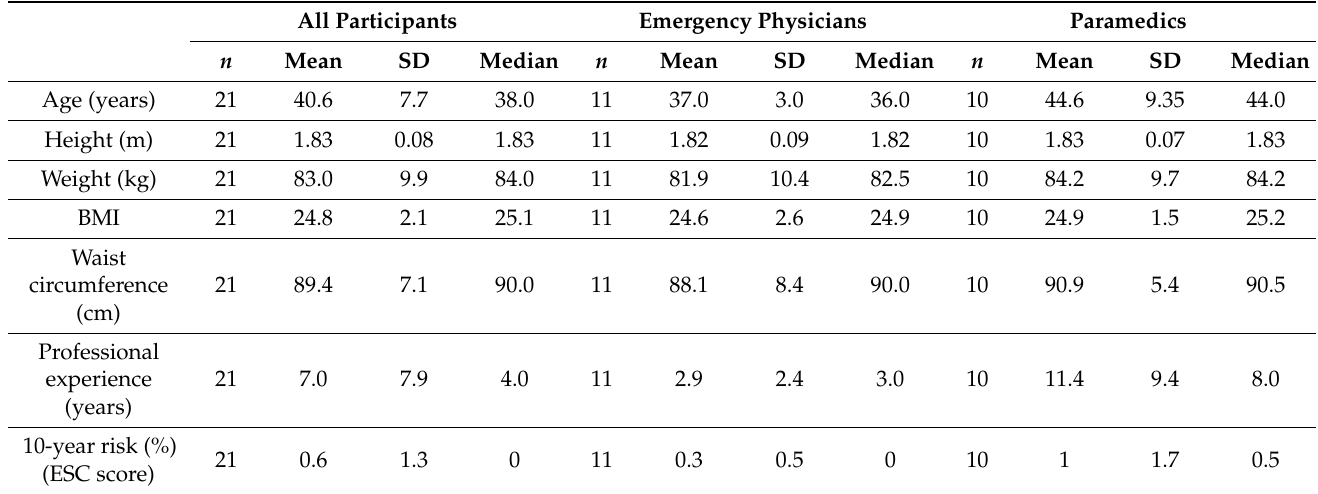
Table 1. Basic characteristics and 10-year risk of the study group (all participants, emergency physicians, paramedics). All